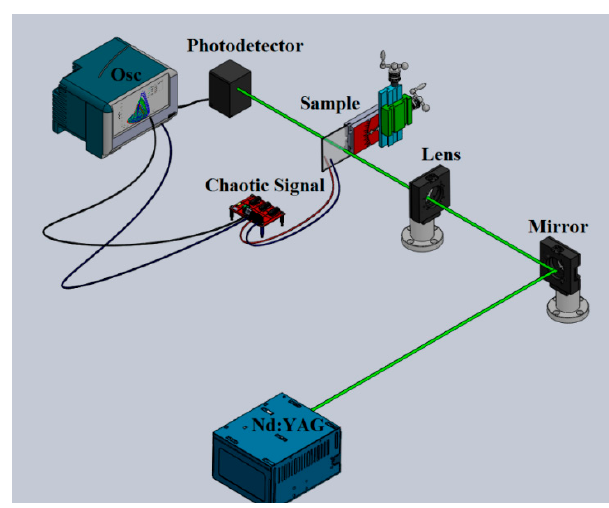
Figure 2. Schematic illustration of the nanosecond single-beam irradiance experiment.